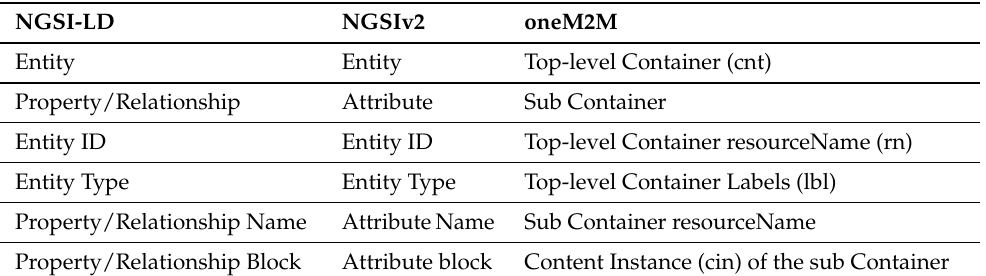
Table 2. NGSI-LD to NGSIv2 and oneM2M. For oneM2M, the Application Entity (AE) name is equal to the vThing name.